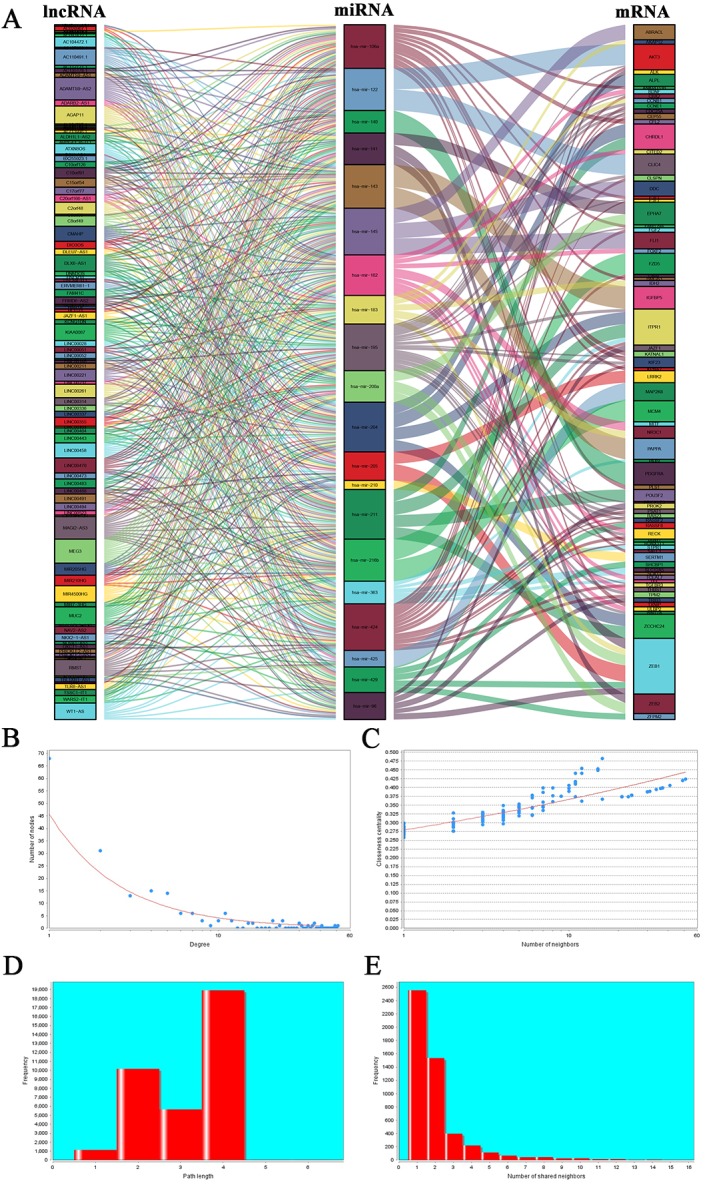
Sankey diagram for the ceRNA network in EC and topology, and stability analysis.(A) Each rectangle represents a gene, and the connection degree of each gene is displayed based on the size of the rectangle. (B) Node degree distribution analysis. (C) Closeness centrality distribution. (D) Shortest path distribution. (E) Node degree distribution density.